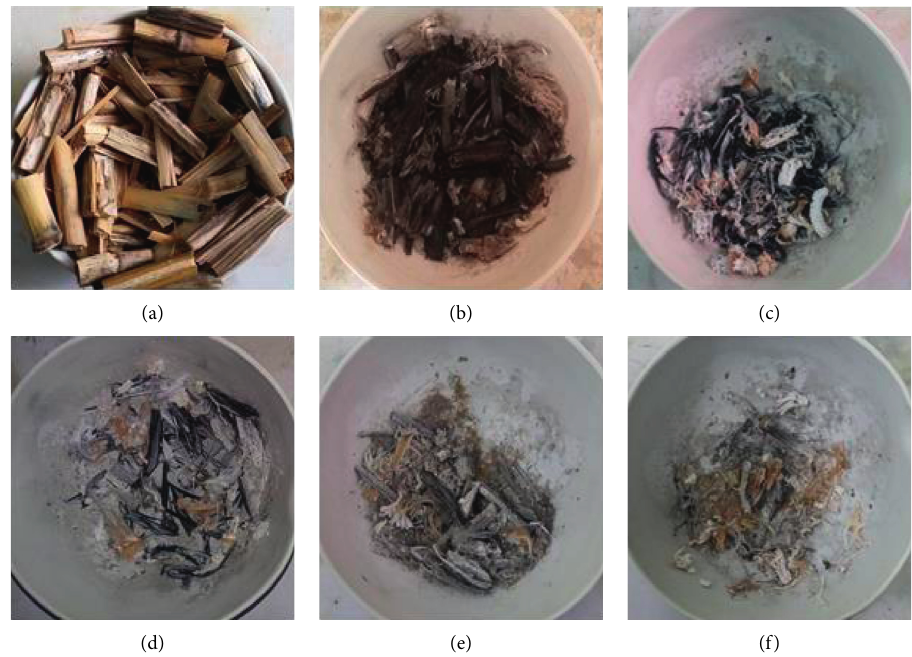
Figure 4: (a) Corn stalk. Color change at different temperatures: (b) CS400, (c) CS500, (d) CS600, (e) CS700, and (f) CS800.